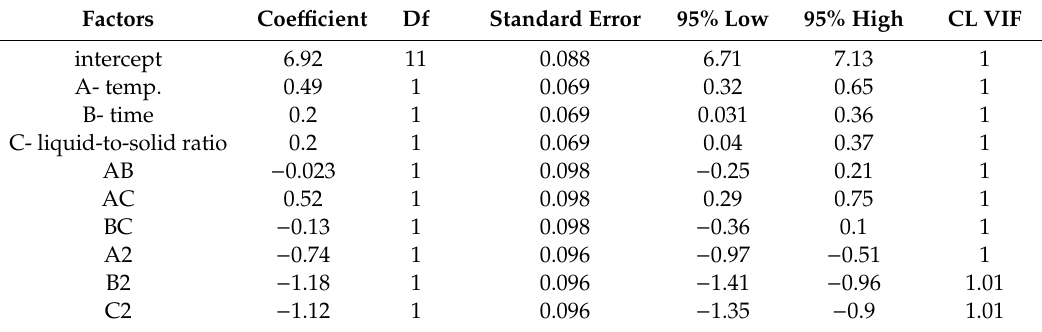
Table 4. Estimated regression coefficients of the fitted second-order polynomial equation. Factors Coefficient Df Standard Error